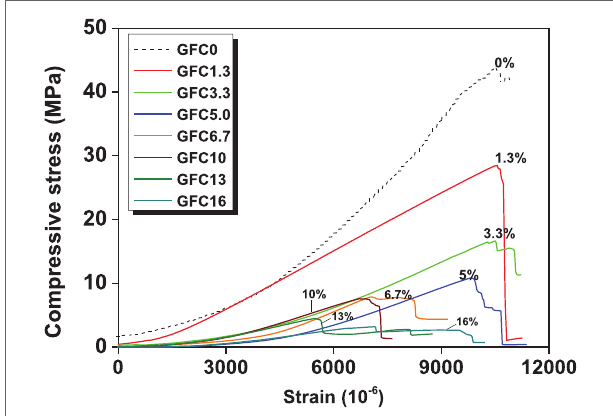
Table 4 | The strength–porosity relationship of gFcs with consideration of separated contributions of large pore P 1 and small pore P 2 . Model regression equations R 2 correlation coefficient FigUre 9 | representative stress–strain curves of the gFcs . The curves show the whole deformation history from the beginning of loading, rather than from a minimum stress that to fix the cylinder, as per BS 1881-121:1983 or ASTM C